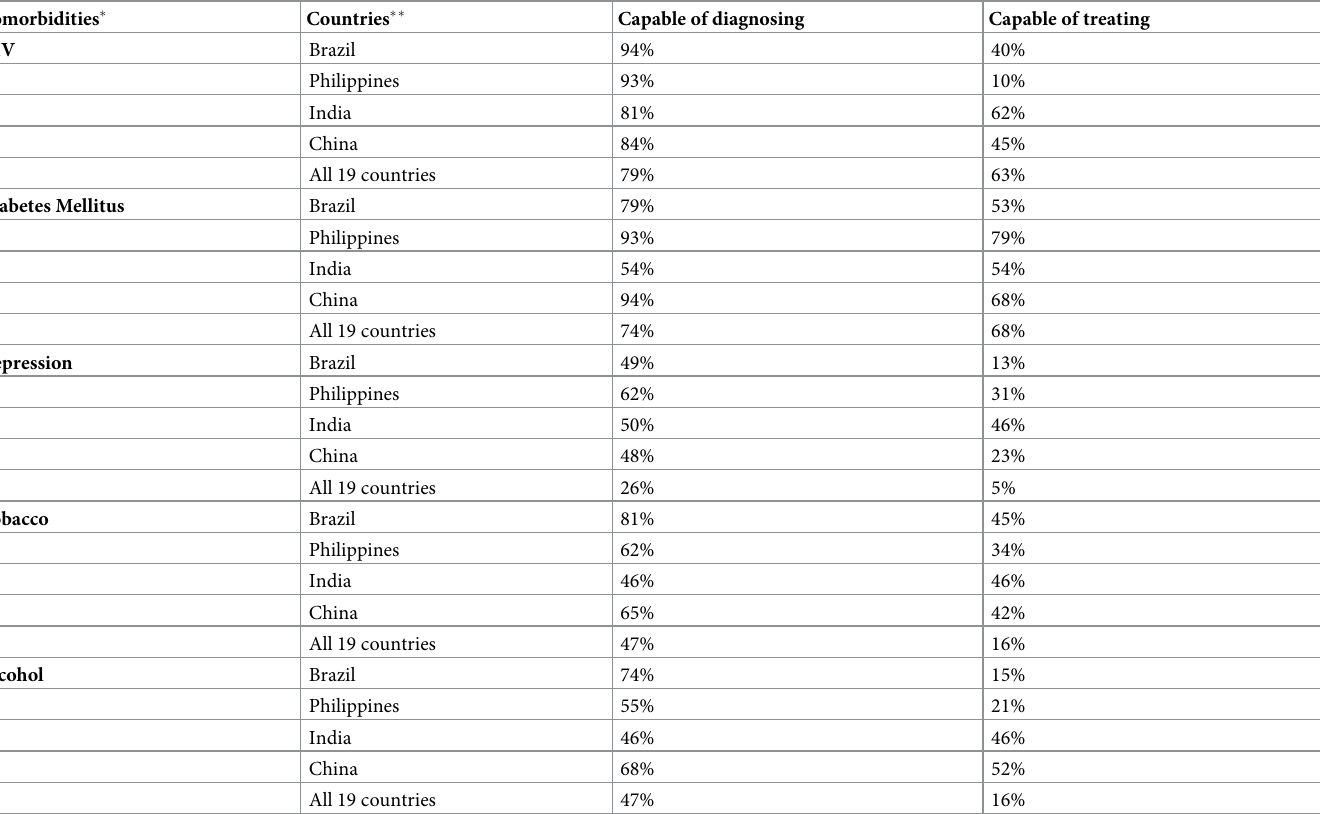
Table 4. Proportion of countries where majority ( > 50%) of TB health professionals thought that they are capable of managing specific comorbidities. Comorbidities �